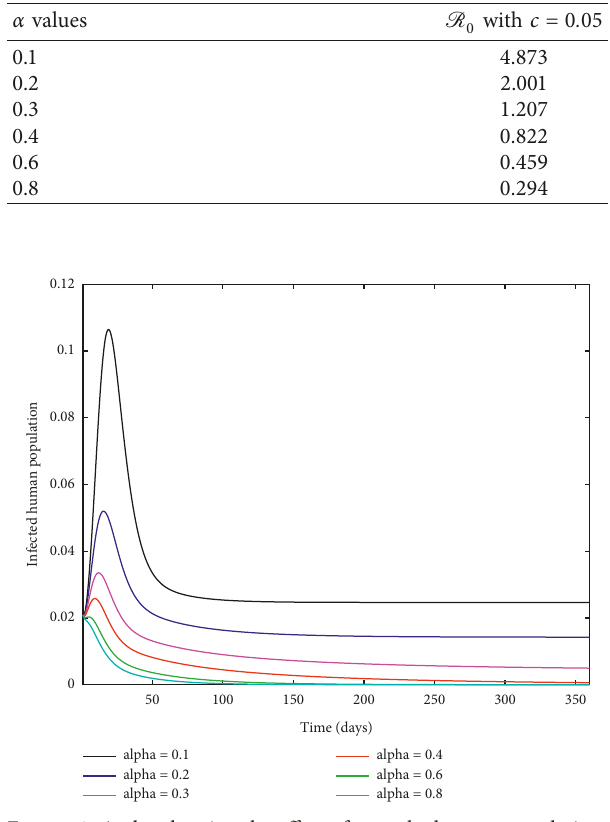
Figure 3: A plot showing the effect of α on the human population.